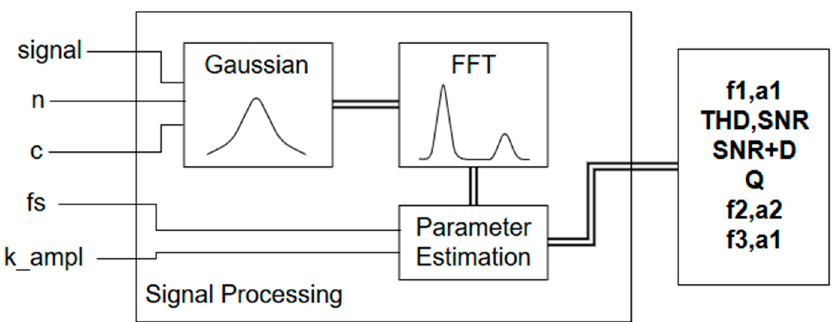
Figure 6. Schema for the signal processing library. The inputs for the system include the analog signal acquired from the sensor (signal), the requested fast Fourier transform (FFT) order, n, the c-parameter for the Gaussian window (c), the sampling frequency (fs) and a calibration factor (k_ampl) for the amplitude. fn and an correspond to the n-harmonic frequency and amplitude values. Total harmonic distortion (THD), signal-to-noise ratio (SNR) and signal-noise ratio+distortion (SNR+D) are also obtained. Q is a quality factor for the signal.